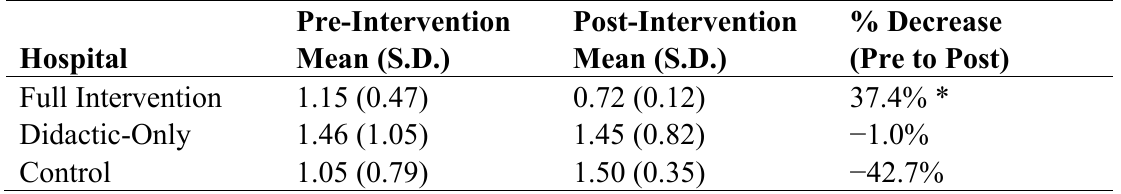
Table 11. Pre-Intervention and Post-Intervention WAOS Means (and Standard Deviations)